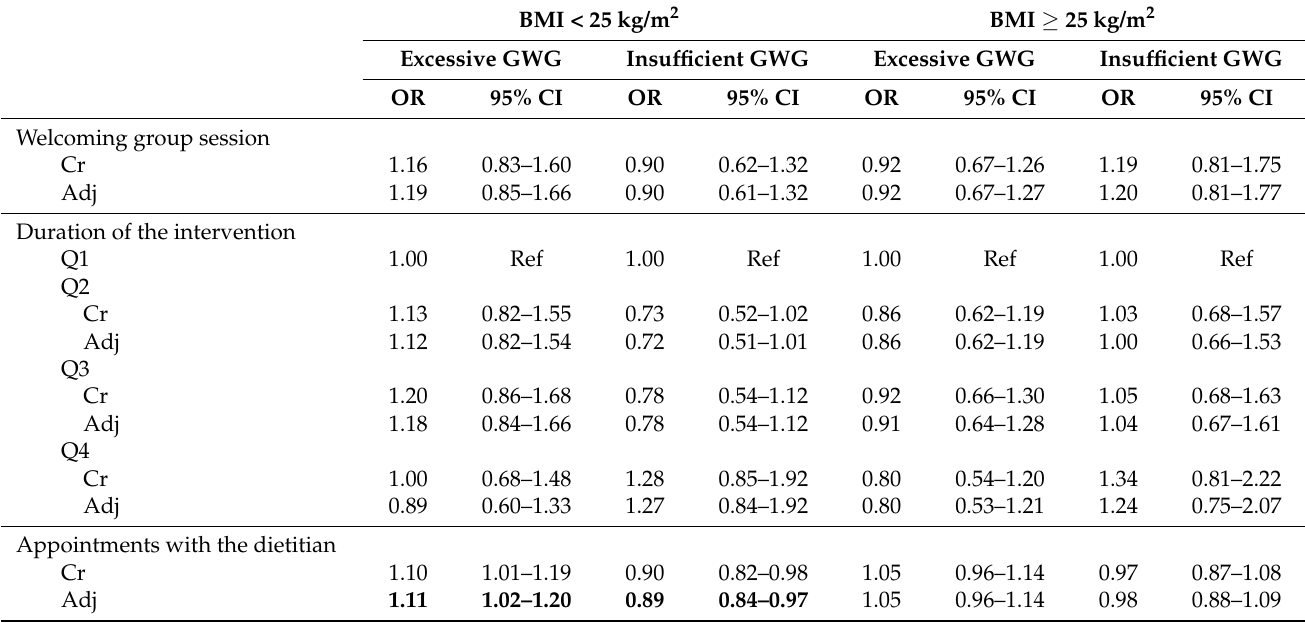
Table 3. Odds ratio of inadequate gestational weight gain (GWG) according to structural features of the intervention, stratified according to pre-pregnancy BMI